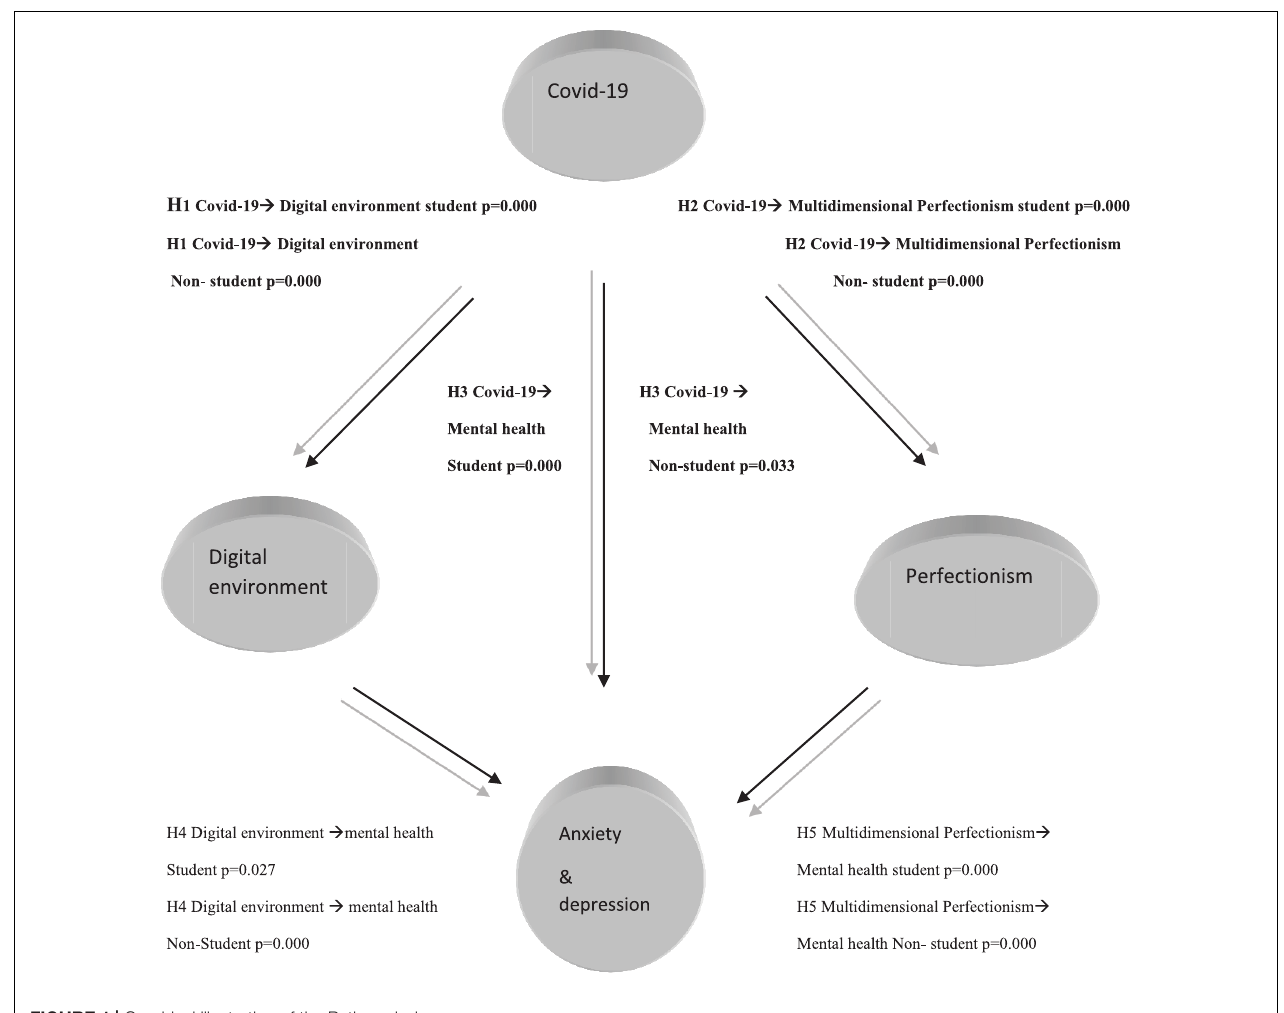
FIGURE 1 | Graphical illustration of the Path analysis.